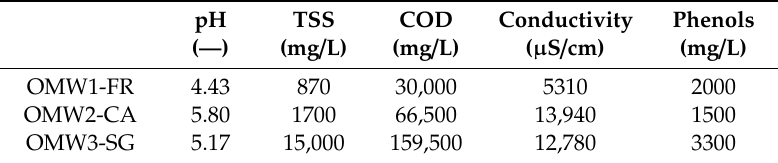
Table 4. Physicochemical properties of OMWs fed to the microfiltration plant.